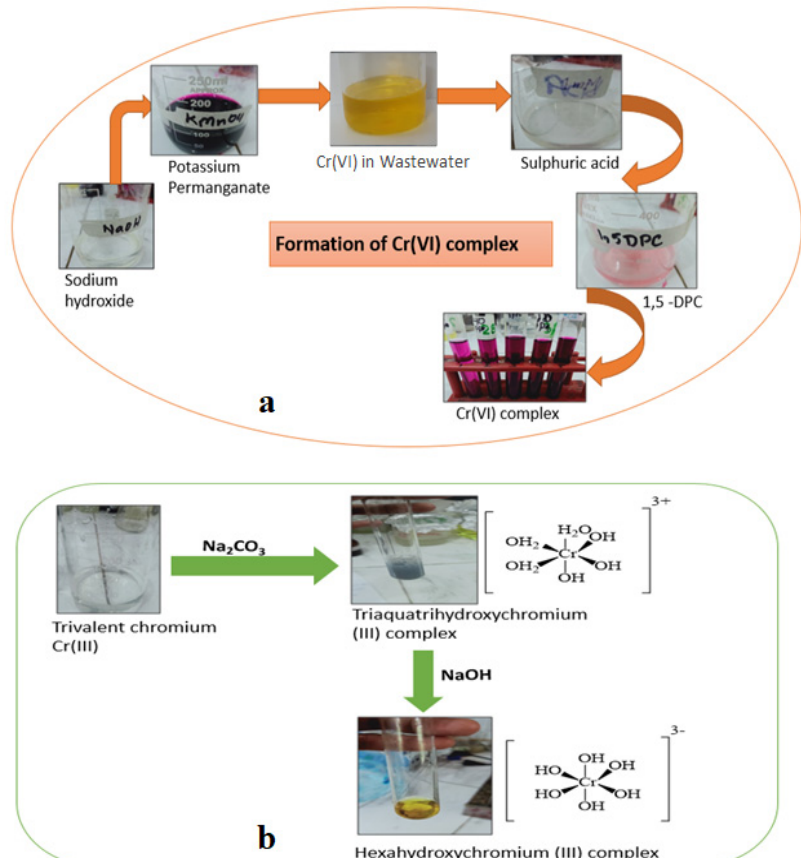
Figure 7. ( a ) Formation of Cr(VI) complex and ( b ) formation of Cr(III) complexes.